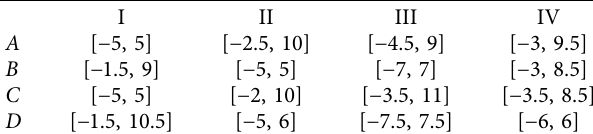
Table 16: Subtraction of the minimum interval in each